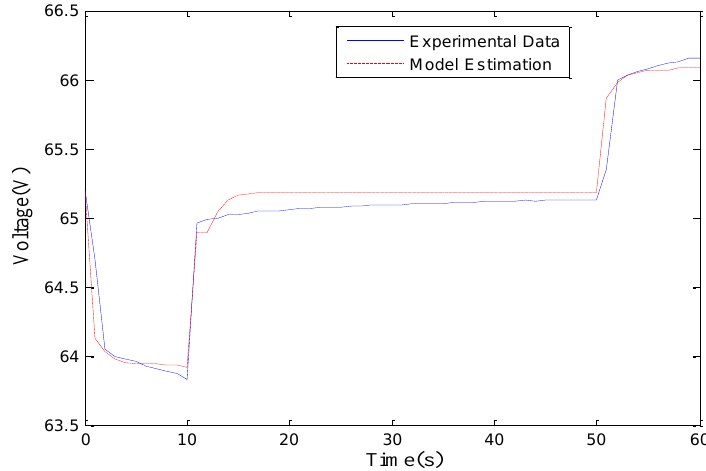
Figure 7. Performance of the optimized battery model in HPPC test at 90%